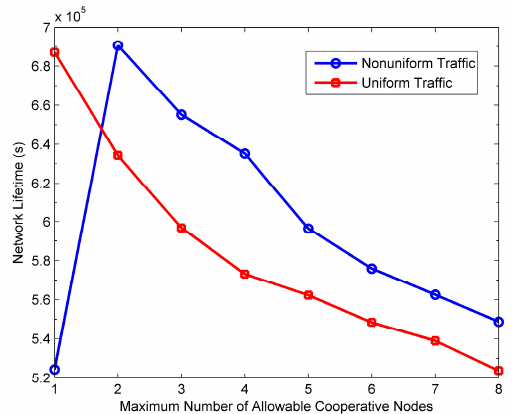
Figure 15. Network lifetime vs. M .